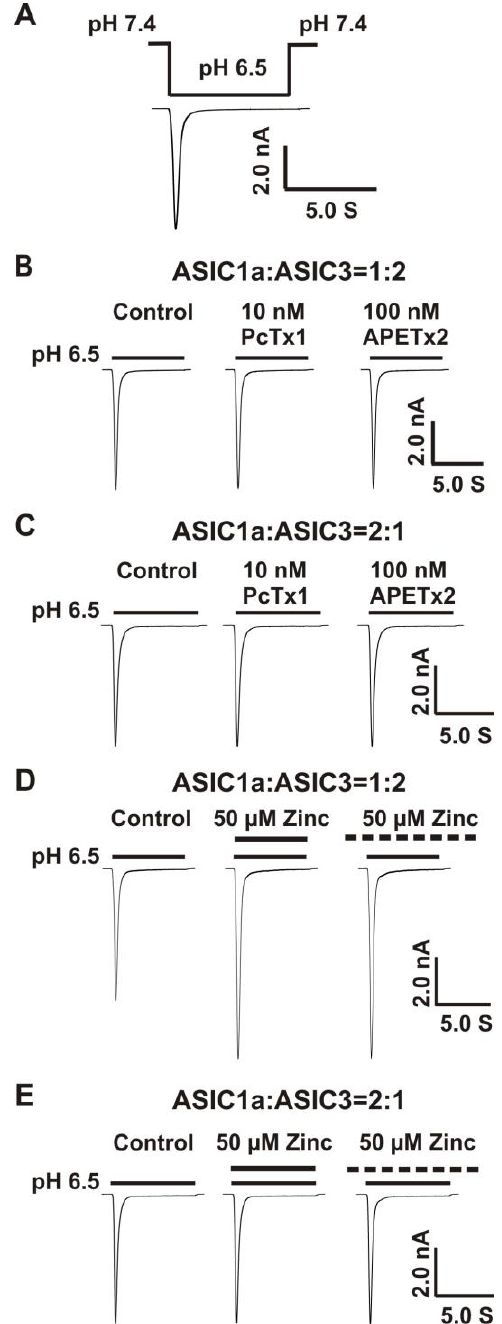
Figure 2. Co-overexpression of 1:2, but not 2:1 ratio of ASIC1a and ASIC3 cDNA revealed a profound response to zinc. ( A ) Activation of heteromeric ASIC1a/3 channels by fast perfusion for a drop in pH from 7.4 to 6.5 on CHO cell expressing both ASIC1a and ASIC3 subunits. The perfusion time for low pH value (e.g., 6.5) is 7 s; ( B ) Representative traces show that PcTx1 (10 nM) and APETx2 (100 nM) have no effects on the heteromeric ASIC1a/3 currents using a 1:2 ratio of ASIC1a and ASIC3, n = 5; ( C ) Representative traces show that PcTx1 (10 nM) and APETx2 (100 nM) also have no effects on the heteromeric ASIC1a/3 currents using a 2:1 ratio of ASIC1a and ASIC3, n = 5; ( D ) Co-application and pretreatment with zinc at 50 µM significantly potentiated the currents of heteromeric ASIC1a/3 using a 1:2 ratio of ASIC1a and ASIC3 (the same cell as Figure 2B), n = 5; ( E ) Co-application and pretreatment with zinc at 50 µM had no effects on the currents of heteromeric ASIC1a/3 using a 2:1 ratio of ASIC1a and ASIC3 (the same cell as Figure 2C), n = 5. Dashed black line represents pretreatment with zinc in pH 7.4 extracellular solution (2 min duration).